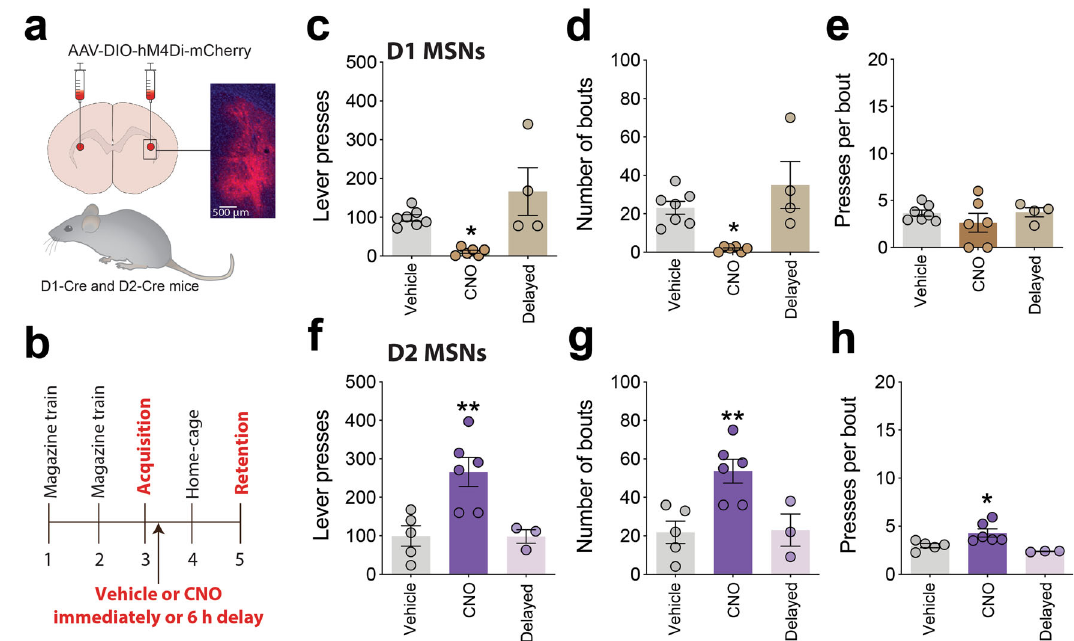
Fig. 5 D1-MSNs in aDLS consolidate new learning and D2-MSNs oppose this process. a Graphical representation of inhibitory Cre-dependent DIO- hM4Di-mCherry DREADD virus delivered to aDLS of D1-Cre and D2-Cre mice, and representative mCherry image from aDLS of virus-injected mouse. b Graphical representation of experimental design. c Mean (±s.e.m.) number of lever presses in D1-mice injected with vehicle ( n = 7 mice), CNO soon after new learning ( n = 6 mice), or CNO 6 h after new learning ( n = 4 mice); F (2, 14) = 8.609, p = 0.0036, One-way ANOVA; * P = 0.0469 compared with vehicle-treated mice, post-hoc test. d Mean (±s.e.m.) number of bouts of lever presses; F (2, 14) = 9.104, p = 0.0029; * P = 0.0226 compared with vehicle- treated mice, post-hoc test. e Mean (±s.e.m.) number of lever presses per bout; F (2, 14) = 0.8103, p = 0.4645. f Mean (±s.e.m.) number of lever presses in D2-mice injected with vehicle ( n = 5 mice), CNO soon after new learning ( n = 6 mice), or CNO 6 h after new learning ( n = 3 mice); F (2, 11) = 8.944, p = 0.0049, One-way ANOVA; ** P = 0.0081 compared with vehicle-treated mice, post-hoc test. g Mean (±s.e.m.) number of bouts of lever presses; F (2, 11) = 8.112, p = 0.0068, One-way ANOVA; * P = 0.0099 compared with vehicle-treated mice, post-hoc test. h Mean (±s.e.m.) number of lever presses per bout (±s.e.m.); F (2, 11) = 7.860, p = 0.0076, One-way ANOVA; * P = 0.0354 compared with vehicle-treated mice, post-hoc